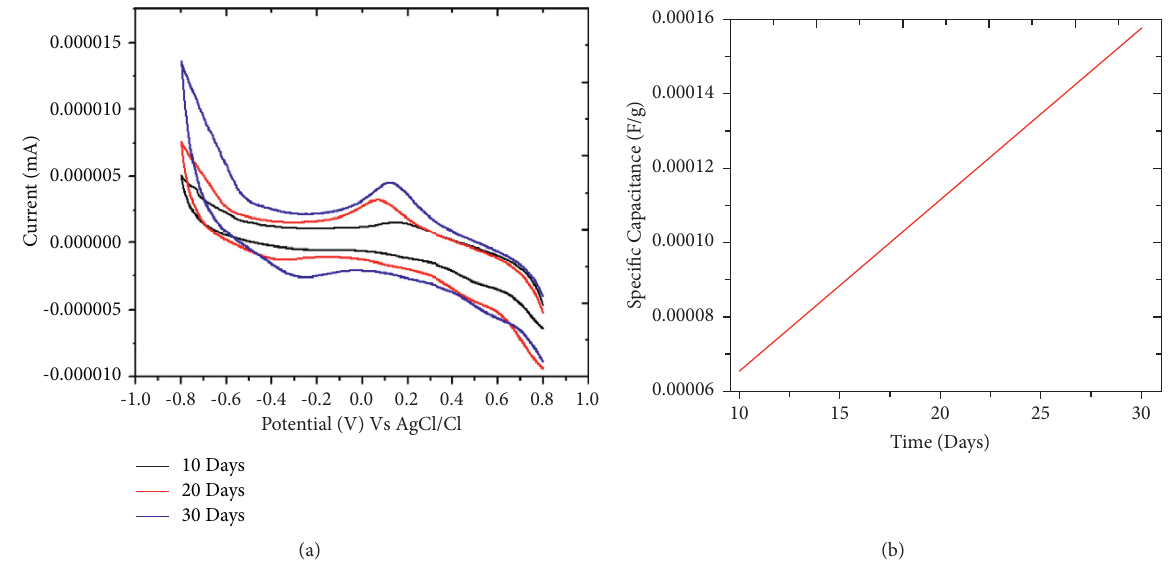
Figure 3: (a) CV curves at different time intervals. (b) C